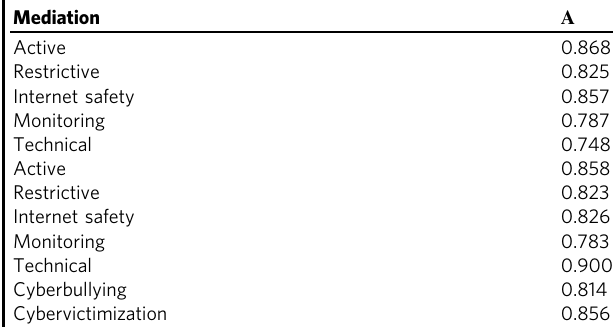
Table 2 Reliability measures for each of the scales used in the